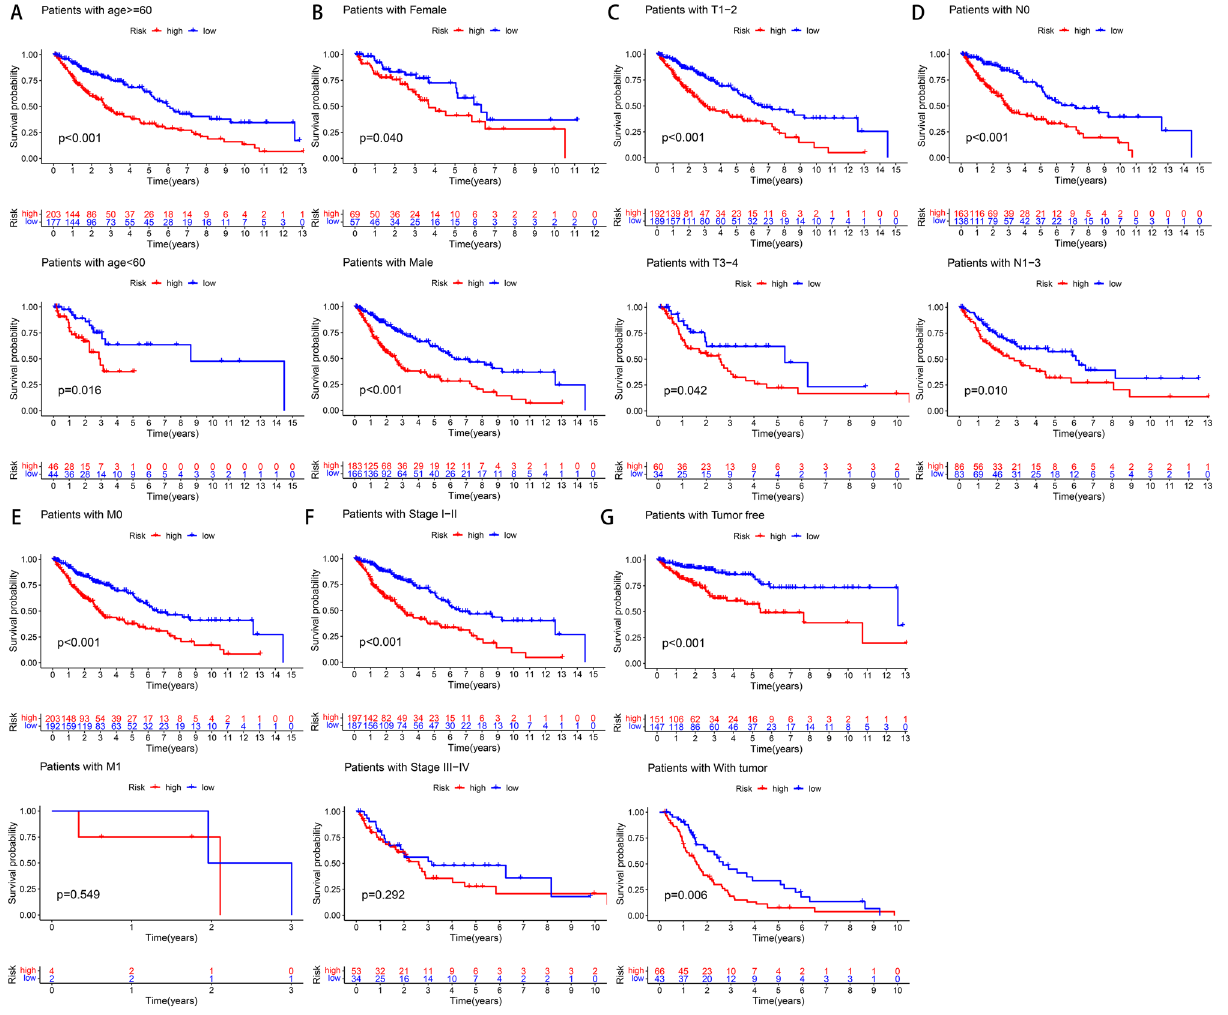
Figure 6. Kaplan–Meier survival curves of LSCC patients in different clinical subgroups. ( A ) Age (≤ 60 or > 60 years old). ( B ) Sex (female or male). ( C ) T (T1–2 or T3–4). ( D ) N (N0 or N1–3). ( E ) M (M0 or M1). ( F ) Stage (I–II or III–IV). ( G ) Cancer status (tumor free or with tumor). TCGA The Cancer Genome Atlas, LSCC lung squamous cell carcinoma, TNM tumor-node-metastasis.